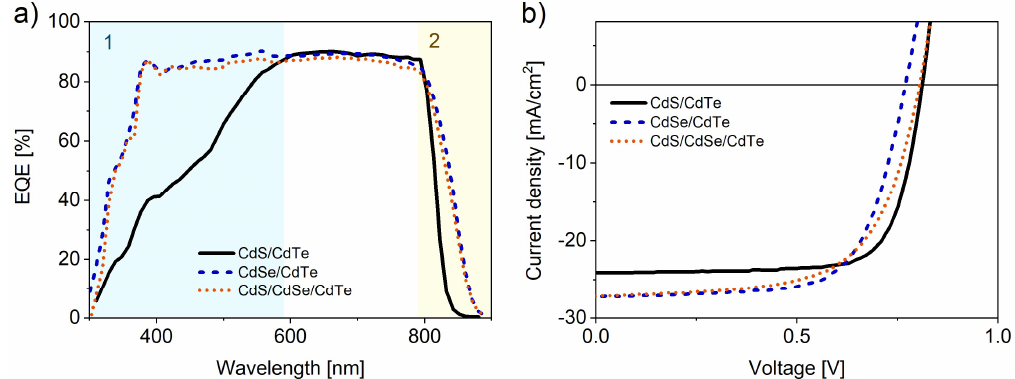
Figure 4. External quantum efficiency (EQE) ( a ) and J - V ( b ) curves of solar cells with different window layers (adapted from [20]). layers (adapted from